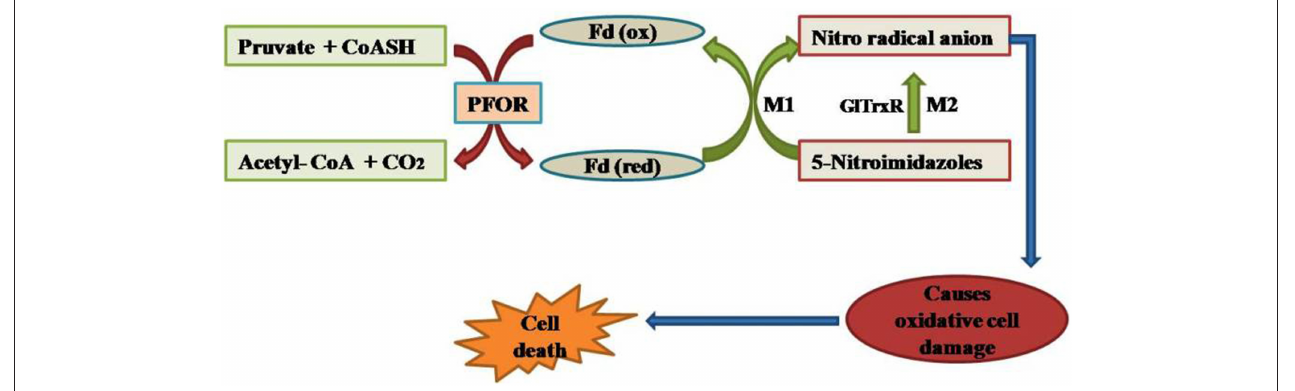
FIGURE 3 | Mode of action of nitroimidazoles in G.